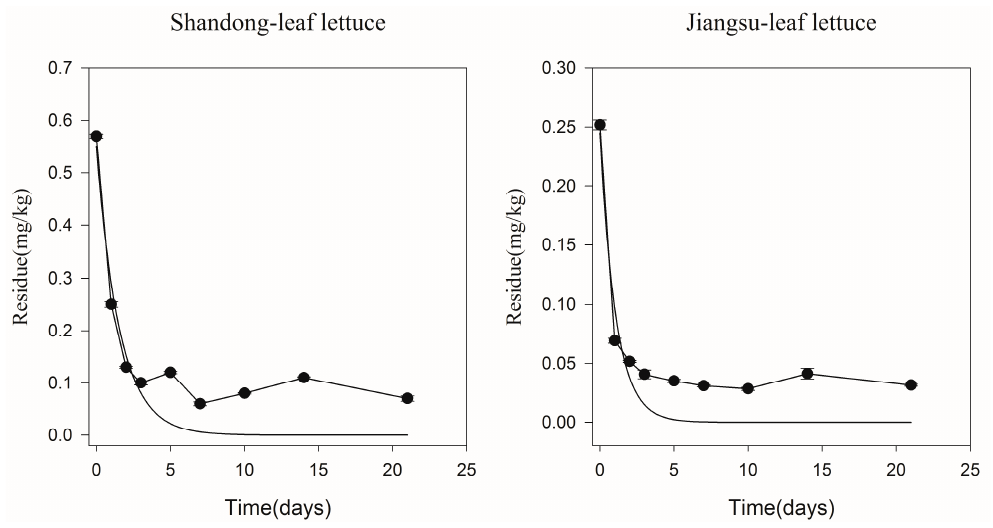
Figure 4. Dissipation of pyrethrins residue in leaf lettuce in Shandong and Jiangsu.